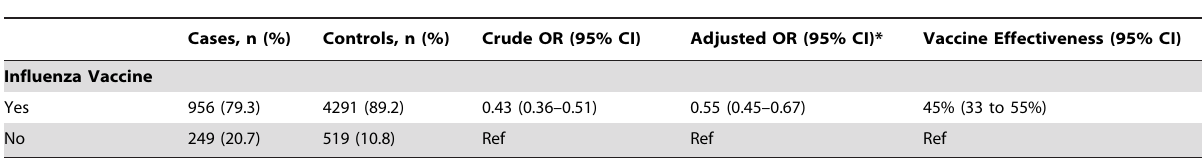
Table 2. Crude and Adjusted OR for Any Vaccine Received in